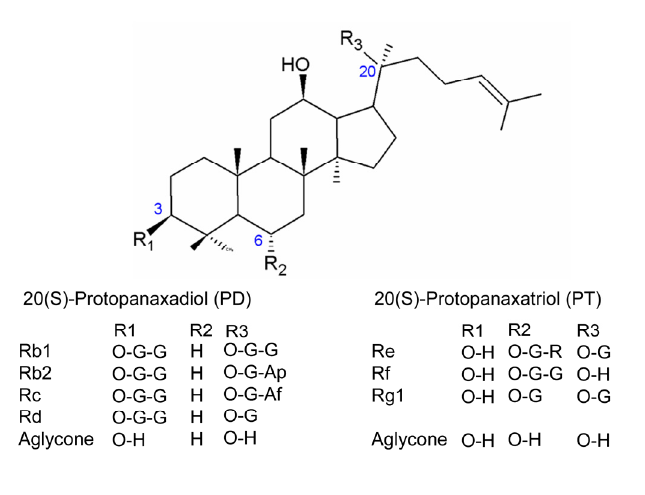
Figure 1. Chemical structure of dammarane type ginsenoside saponins found in the experimental Panax ginseng extract (PGE). Regions R1-R3 consists of different attachment of sugar moiety molecules and to the